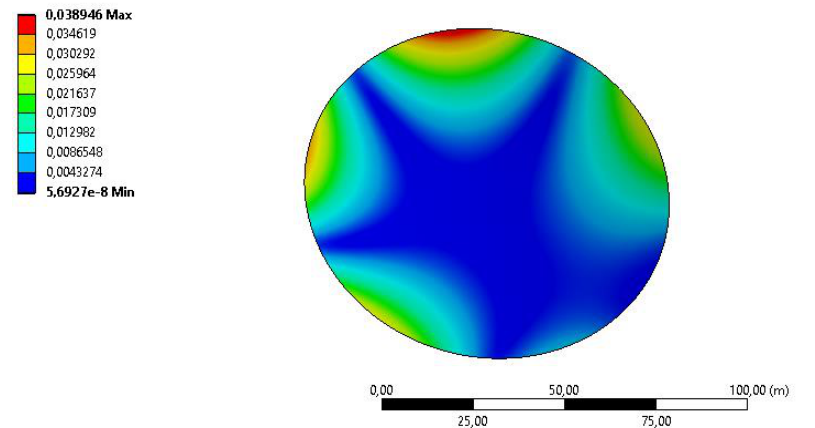
Fig. 4. Total displacements of the mesh sheet of the transformable antenna reflector,